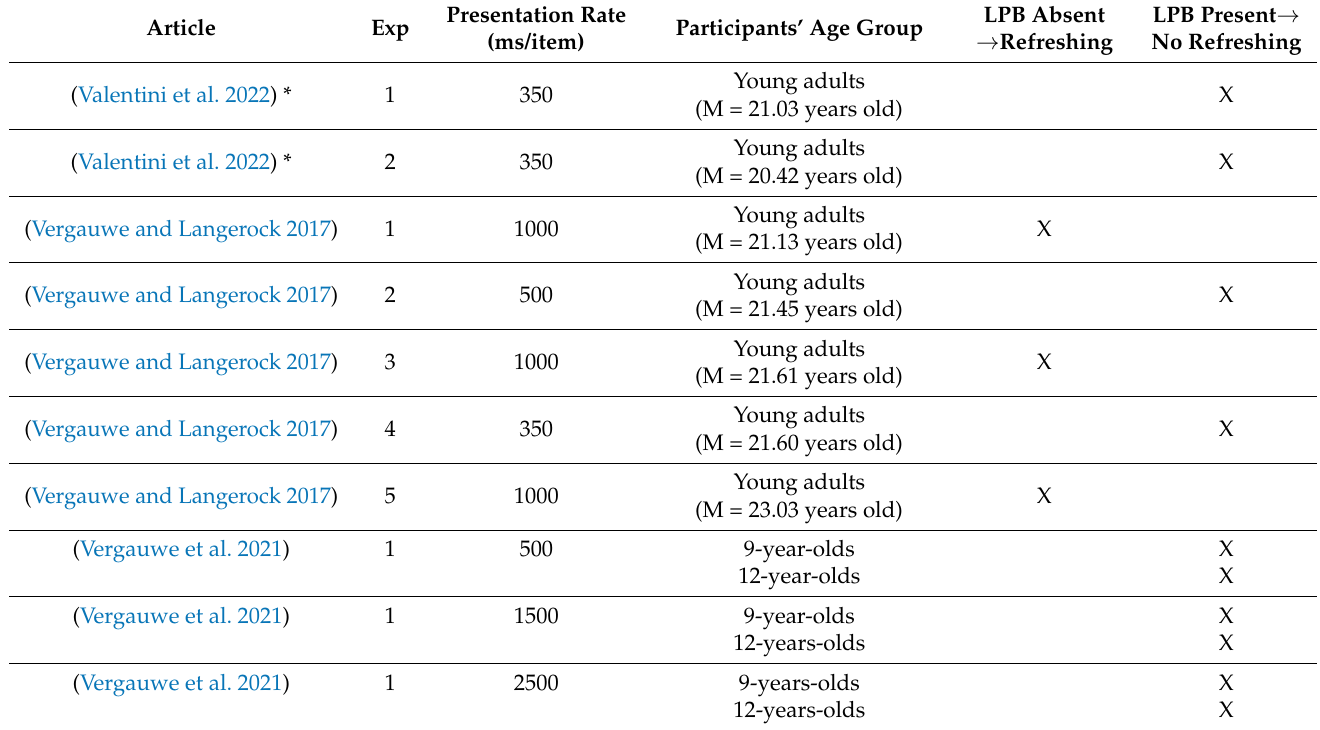
Table 1. Studies supporting the occurrence of refreshing vs. a last-presented benefit in young children and